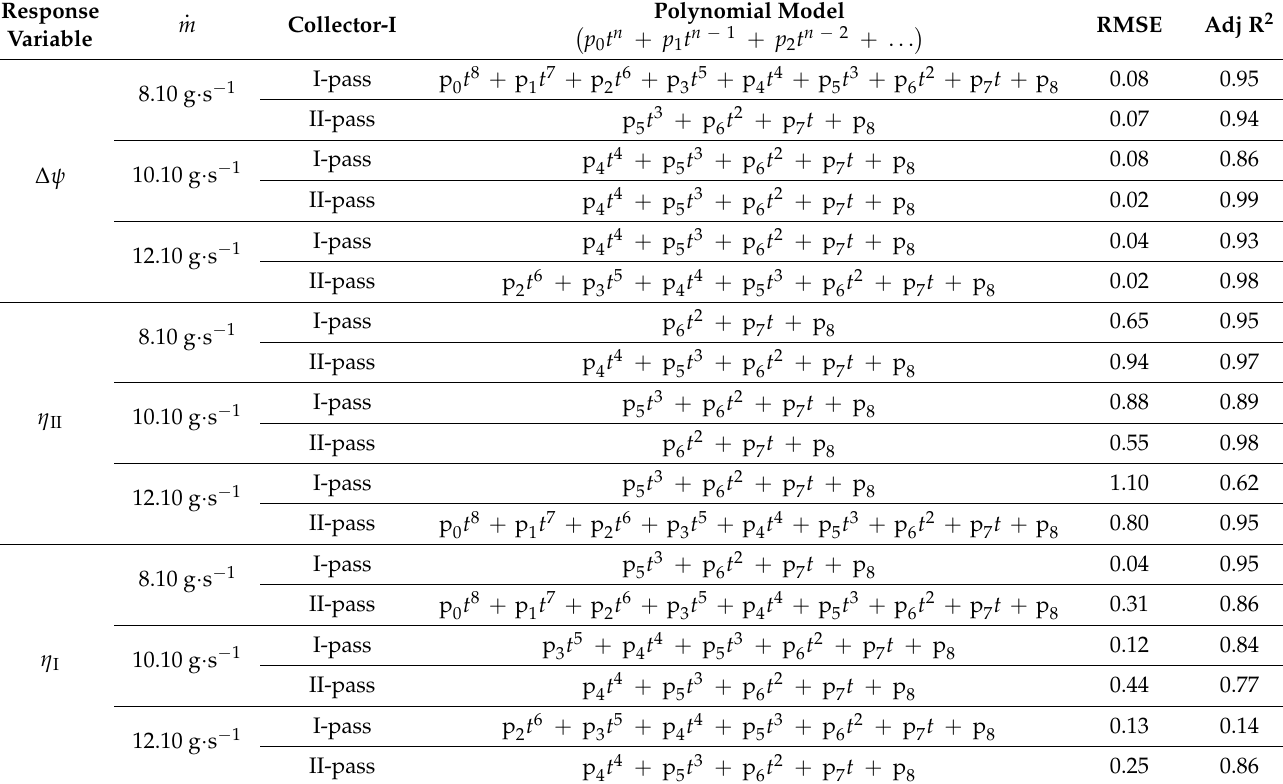
Table 2. The mathematical relation of ∆ ψ , η II and η I with time, and t for